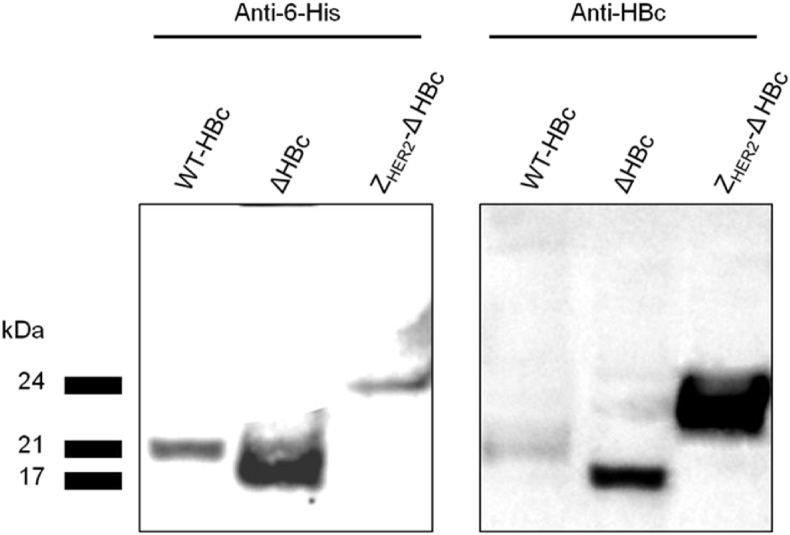
Immuno-specificity of HBc particles by Western blotting. Denatured HBc samples were subjected to SDS-PAGE followed by immune-blotting using anti-6-His and anti-HBc antibodies. Results confirmed the presence of specific protein bands at the expected molecular weight band; 21 kDa, 17 kDa and 24 kDa for WT-HBc, ΔHBc and ZHER2-ΔHBc, respectively.